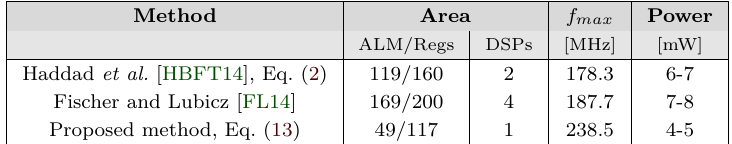
Table 3: Summary of implementation results of the variance measurement method based on counter differences compared to other state-of-the-art methods implemented in the dedicated evaluation board featuring Intel Cyclone V FPGA device 5CEBA4F17C8N